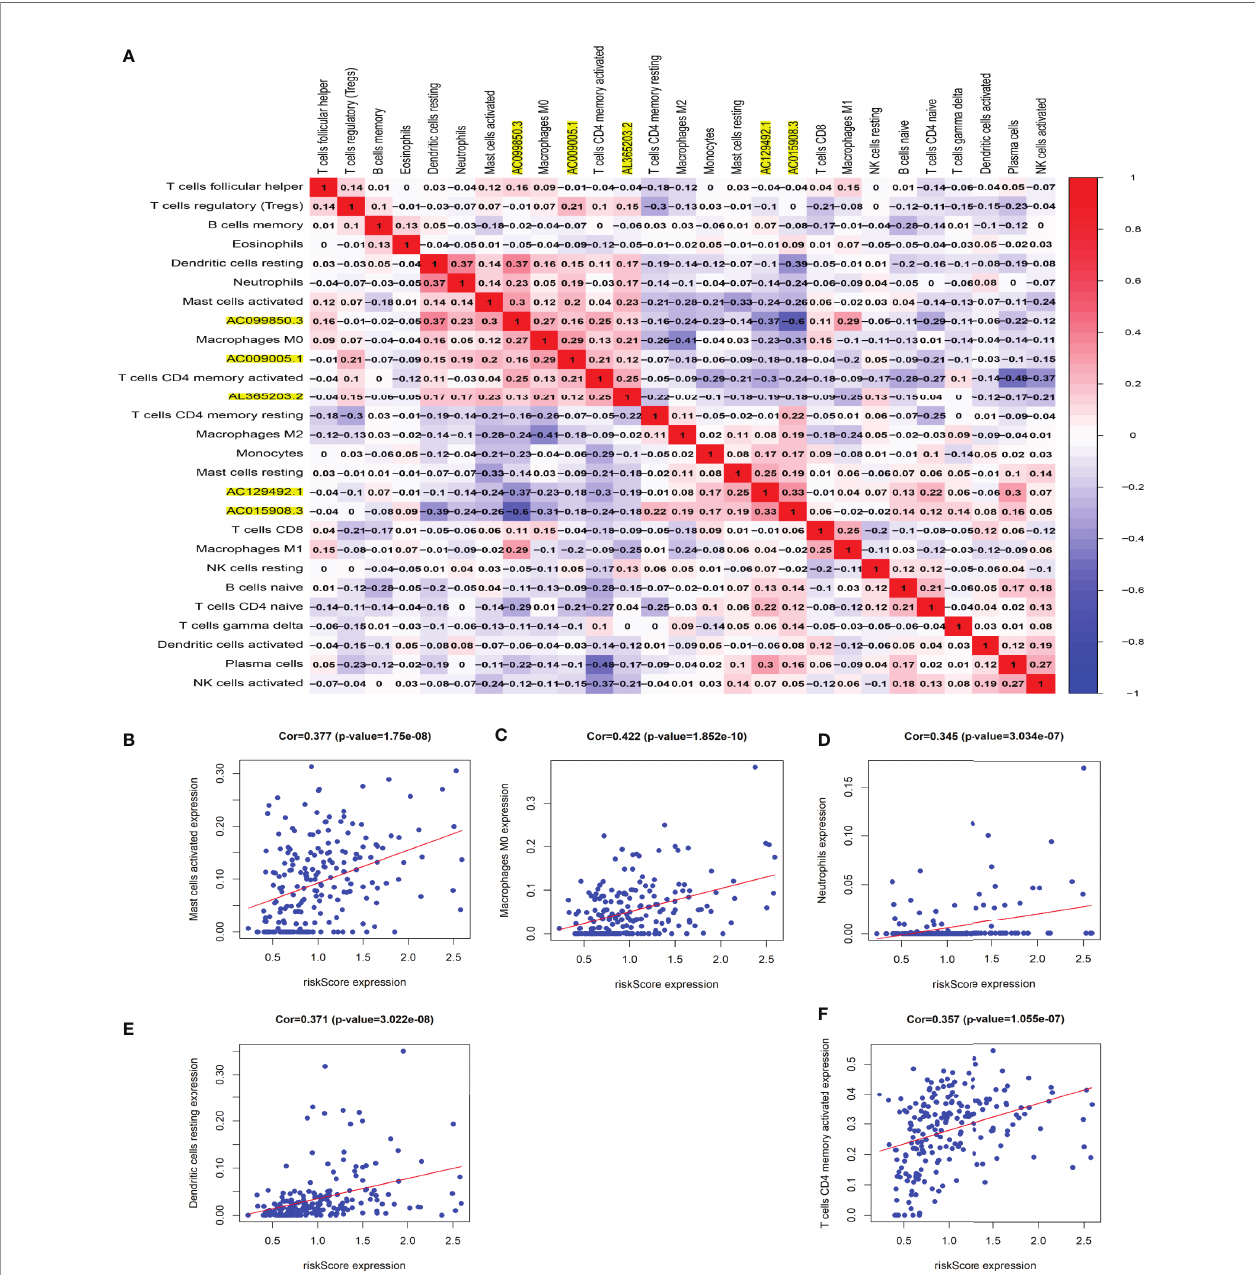
FIGURE 7 | Relationship between immune cell in fi ltration and the model based on fi ve immune-related lncRNAs. (A) The co-expression heat map shows some important co-expression patterns of members of fi ve immune-related lncRNAs and key members of immune cells. (B – F) The relation between risk scores and in fi ltration of the fi ve types of immune cells (activated mast cells, M0 macrophages, neutrophils, resting dendritic cells, and activated CD4 memory T